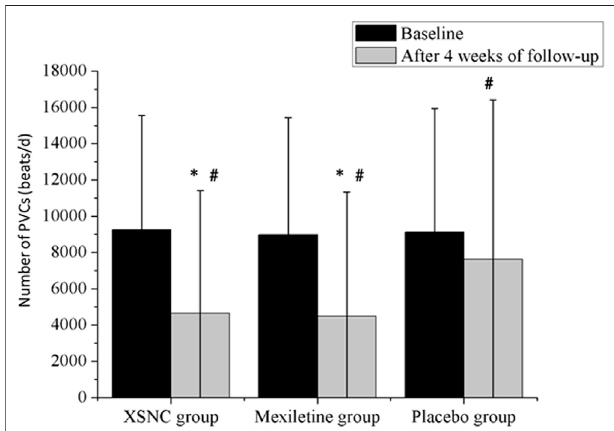
FIGURE 3 | Total number of PVCs from baseline to 4 weeks after treatment in the trial groups. PVCs, premature ventricular contractions. # p < 0.001 vs. baseline, * p < 0.001 vs. the placebo group. Continuous data were presented as the mean ± standard deviation (SD). A smaller number of PVCs were observed after a 4-week treatment than at baseline, in the XSN group (4645.89 ± 6,772.17vs.9,250.56 ± 6,297.37beats/d, p < 0.0001), the mexiletine group (4480.37 ± 6,851.37 vs. 8,983.23 ± 6,439.02 beats/d, p < 0.0001), and the placebo group (7,617.16 ± 8,794.66 vs. 9,129.63 ± 6,796.15 beats/d, p < 0.0001). In addition, compared to the placebo group, theXSNgroupandthemexiletinegrouphadastatisticallysigni fi cantchangein the total PVC frequency after the 4-week treatment period ( p < 0.0001) (Ma et al., 2020).